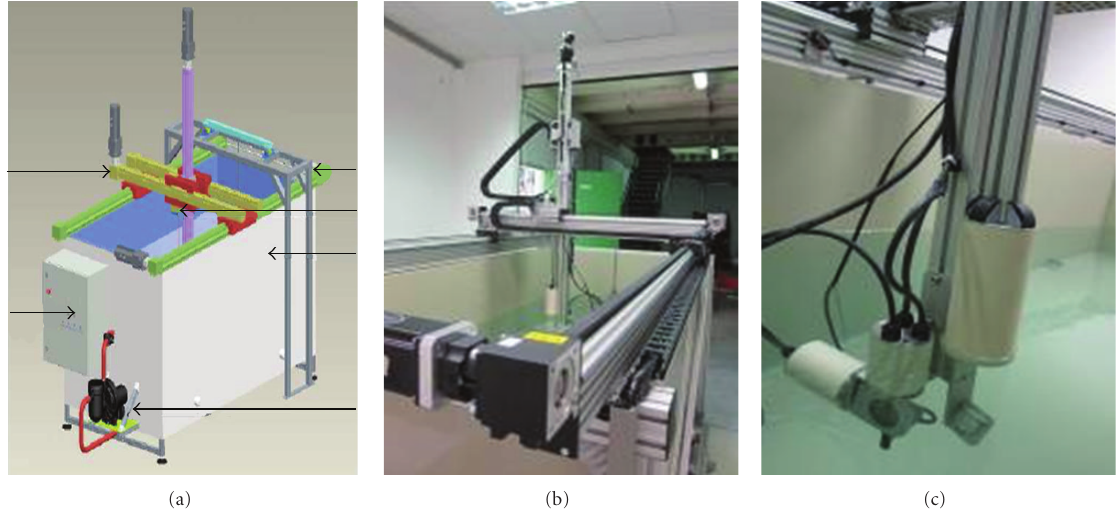
Figure 20: VISIO water facility (2m long, 1m large, and 1 m high) devoted to ultrasonic visualization